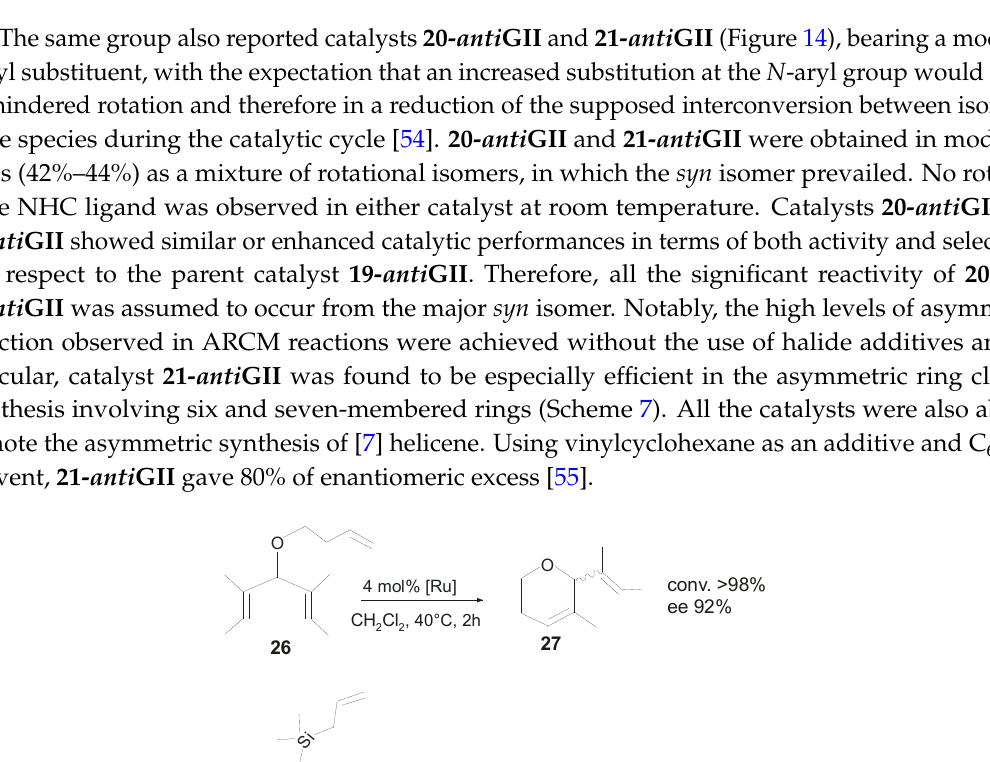
Scheme 7. Asymmetric ring closing metathesis of 26 and 28 catalyzed by 21- anti GII .